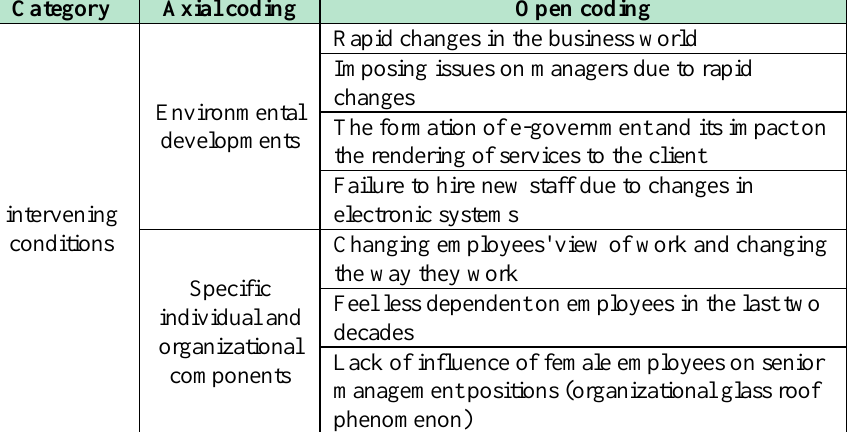
Table 5 - Open coding of qualitative data (intervening conditions)